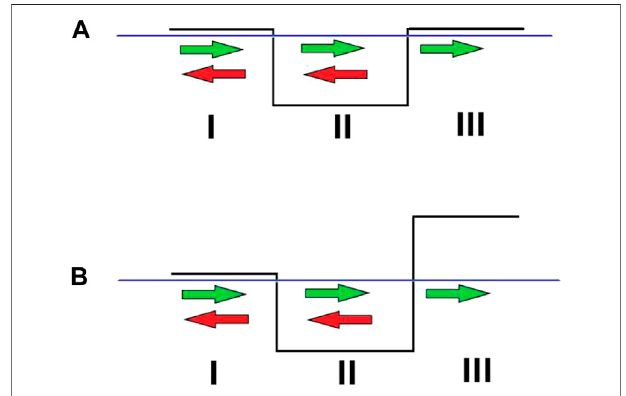
FIGURE 1 | (A) Symmetric and (B) asymmetric potential well [63].